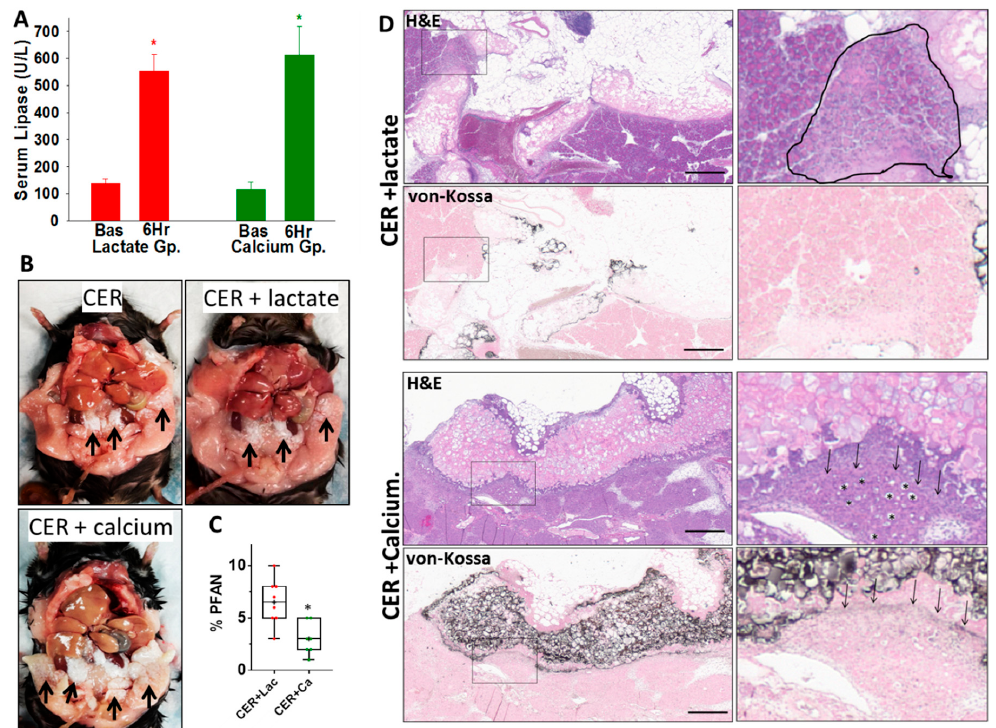
Figure 4. Comparison of the therapeutic calcium and lactate on fat necrosis during severe experimental pancreatitis: ( A ) serum lipase levels as measured under basal (Bas) conditions before induction of pancreatitis and after 6 h of pancreatitis (6 H), following which either Sodium lactate or Calcium chloride were given intraperitoneally, as described in the methods section. ( B ) Gross appearance of the peritoneal cavity at necropsy of mice with caerulein pancreatitis alone (CER) , caerulein pancreatitis treated with sodium lactate (CER + lactate), or caerulein pancreatitis treated with calcium chloride (CER + calcium). Note the much larger extent of white- colored saponification of fat necrosis in the calcium-treated group (black arrows). ( C ) Box plots comparing the extent of peri-fat acinar necrosis (% PFAN) measured as a percentage of total pancreatic parenchymal area in the CER + lactate (CER + Lac)- and CER + calclium (CER + Ca)-treated groups. * indicates a p < 0.05. ( D ) Histologic images of the pancreas and adjacent fat necrosis stained with hematoxylin and eosin (H&E), and von-Kossa for calcium, in the CER + lactate and CER + calcium groups. To the right are zoomed-in images of the inset boxes highlighting the peri-fat acinar necrosis adjacent to the fat necrosis. The scale bar is 200 µm. Fat necrosis resulting in binding of calcium to the NEFA generated is seen as the pinkish stain in adipose tissue on H&E. Note the higher intensity of this in the CER + calcium group using both types of staining, especially von-Kossa, which extends into the parenchyma as a sharply demarcated line (black arrows). The peri-fat acinar necrosis is seen as loss of acinar cell outline and diffuse pale pinkish appearance of acini replacing the normal intensely pink zymogen and blue-colored basal cytoplasm. In the CER + calcium group, which survive longer, the prolonged caerulein stimulation results in acinar ductal metaplasia-like appearance with large central lumens replacing the zymogen (shown as *). 3.7. Therapeutic Extracellular Calcium Supplementation Prevents Hypocalcemia, and Transiently Reduces